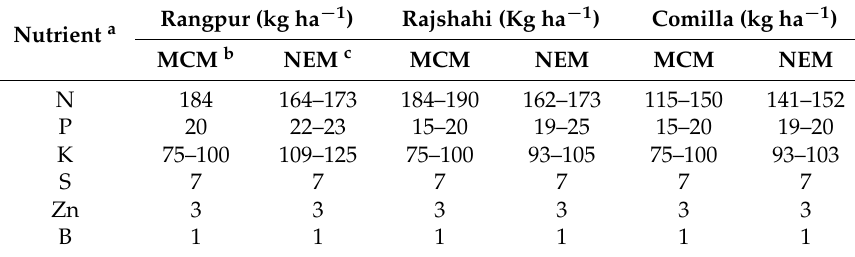
Table 3. Fertilizer recommendations for three field experimental sites in Bangladesh based on Maize Crop Manager (MCM) and Nutrient Expert for Maize